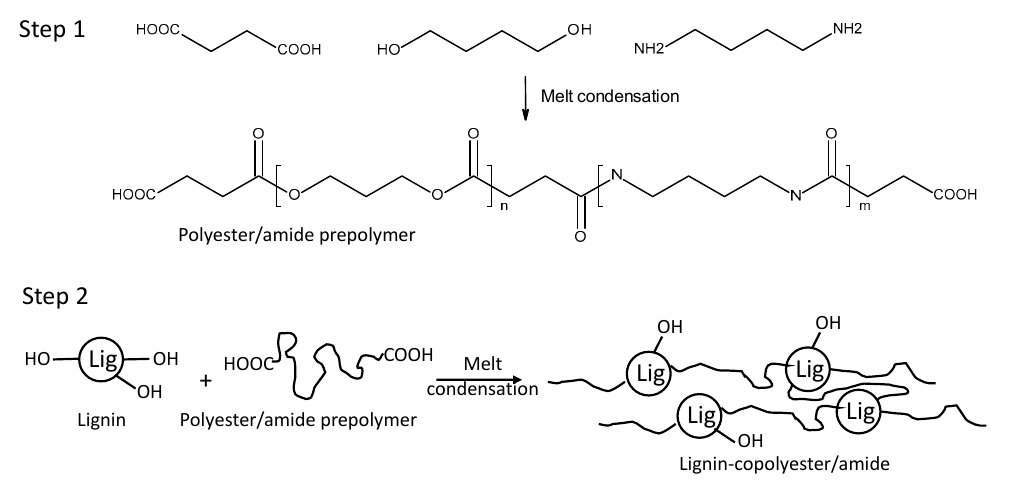
Figure 1. Schematic showing the 2-step process for producing the polybutylene-succinate/succinamide prepolymer and lignin-copolyester/amides (lignin-copolybutylene-succinate/succinamide).